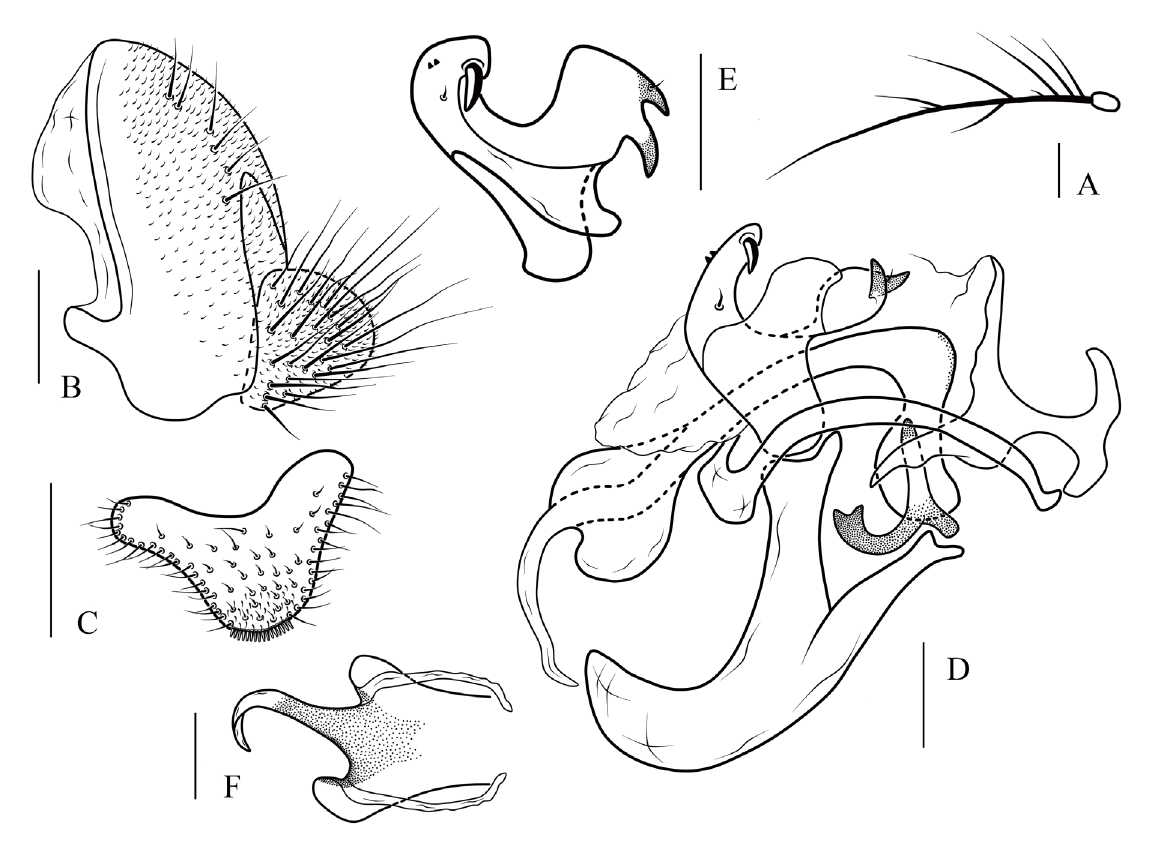
Fig. 2. Phortica ( Phortica ) jadete sp. nov., ♂. A . Arista. B . Epandrium and cercus (lateral view). C . Surstylus (frontal view). D . Hypandrium, paramere, aedeagus and aedeagal apodeme (lateral views). E . Paramere (frontal view). F . Tip of aedeagal median rod (ventral view). Scale bars = 0.1